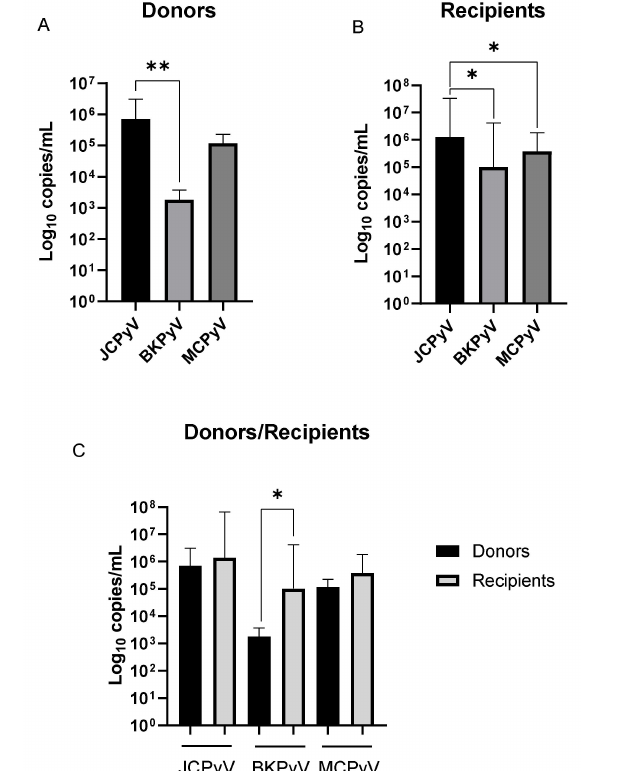
Figure 1. Median (IQR) virus-specific urinary loads in donors’ ( A ) and recipients’ ( B ) groups; direct comparison between donors’ and recipients’ median (IQR) virus-specific urinary loads ( C ). p values: ** p = 0.0043 (A), * p = 0.0166 (JCPyV vs. BKPyV and * p = 0.0158 JCPyV vs. MCPyV (B), * p = 0.0107